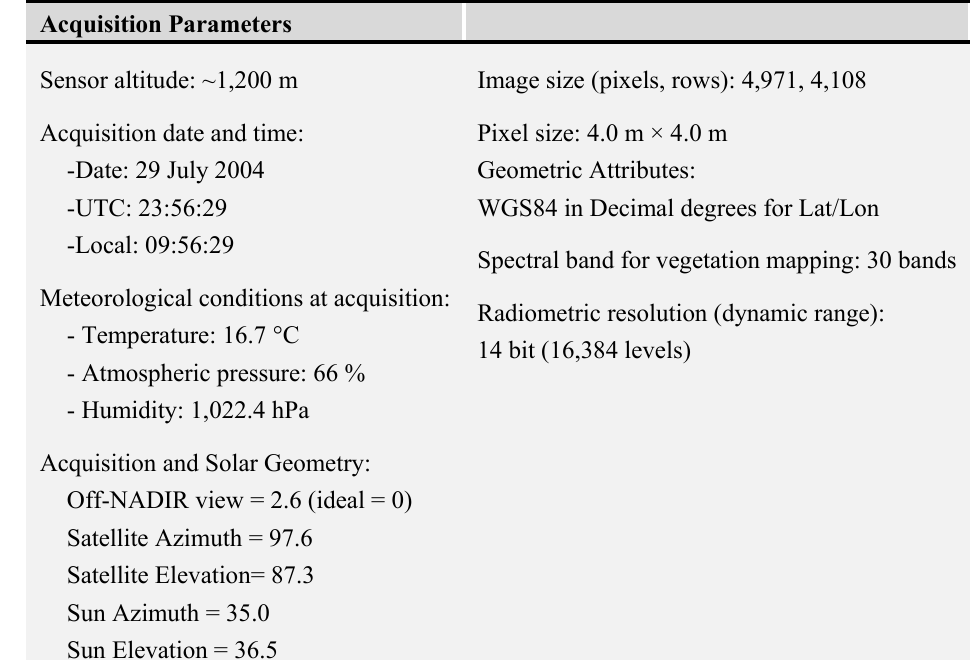
Table 1. Summary of image dataset collection parameters CASI-2 and band set used for mangrove mapping (Source: